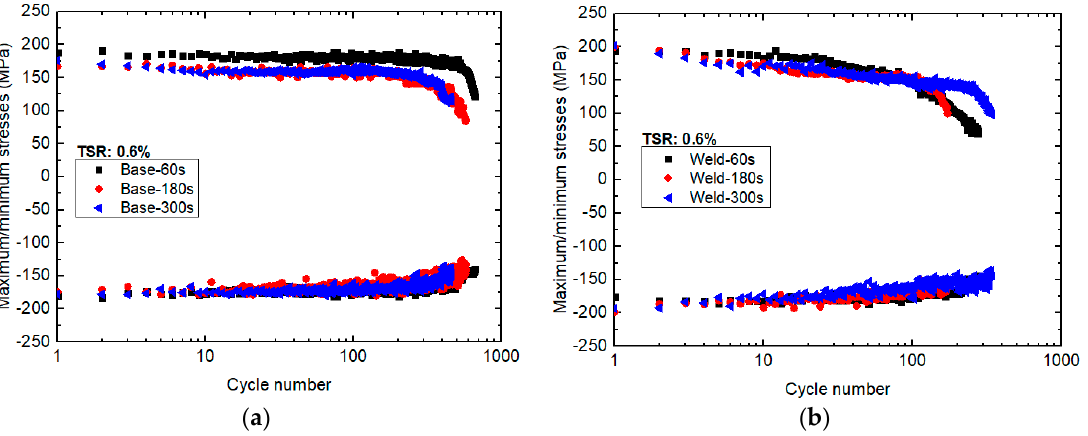
Figure 6. Maximum/minimum stresses vs. cycle number curves of Alloy 617: ( a ) Base metal; ( b ) Weldments.